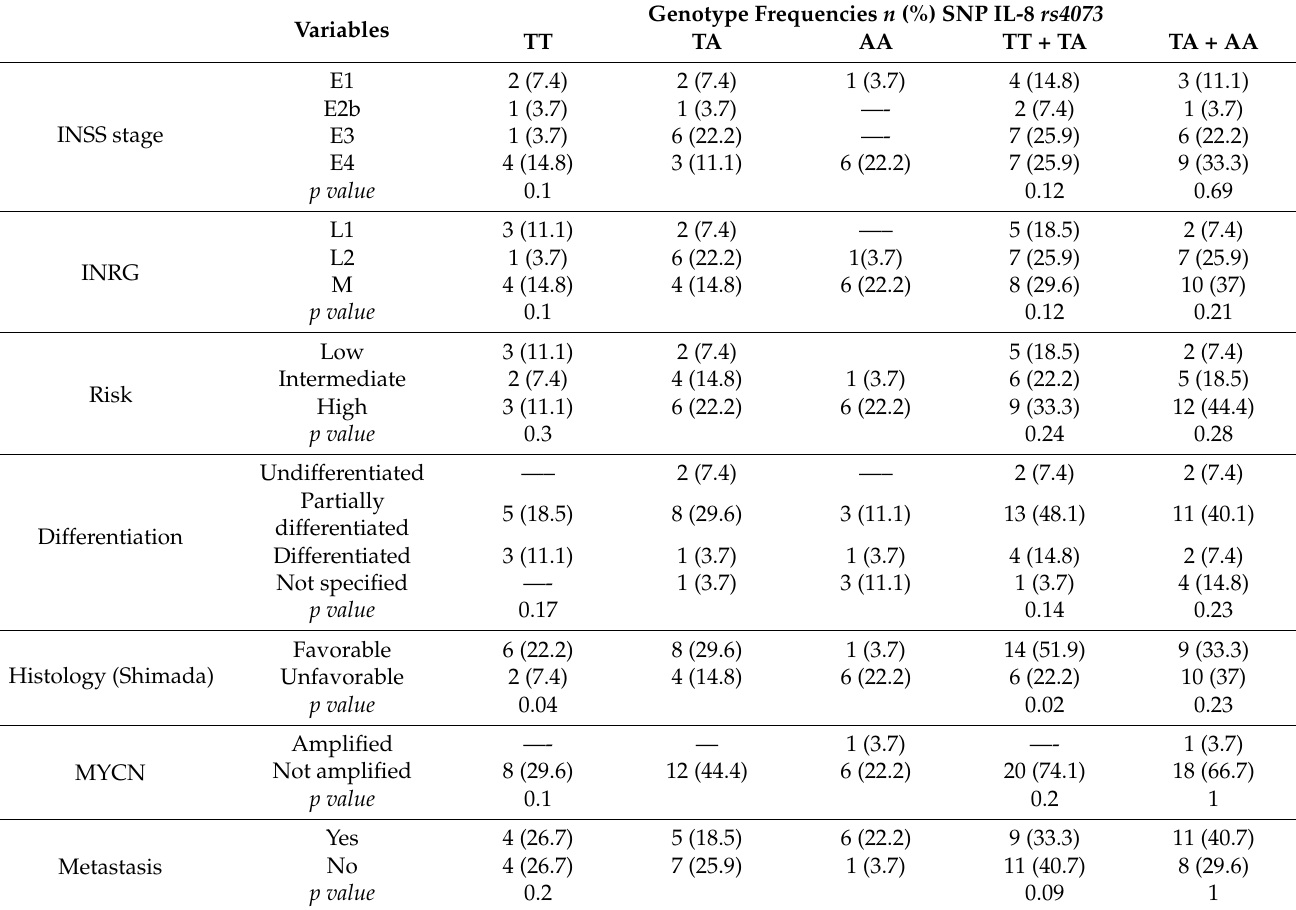
Table 4. Genotype frequencies of the gene IL-8 − 251 T > A rs4073 and prognostic factors of NB